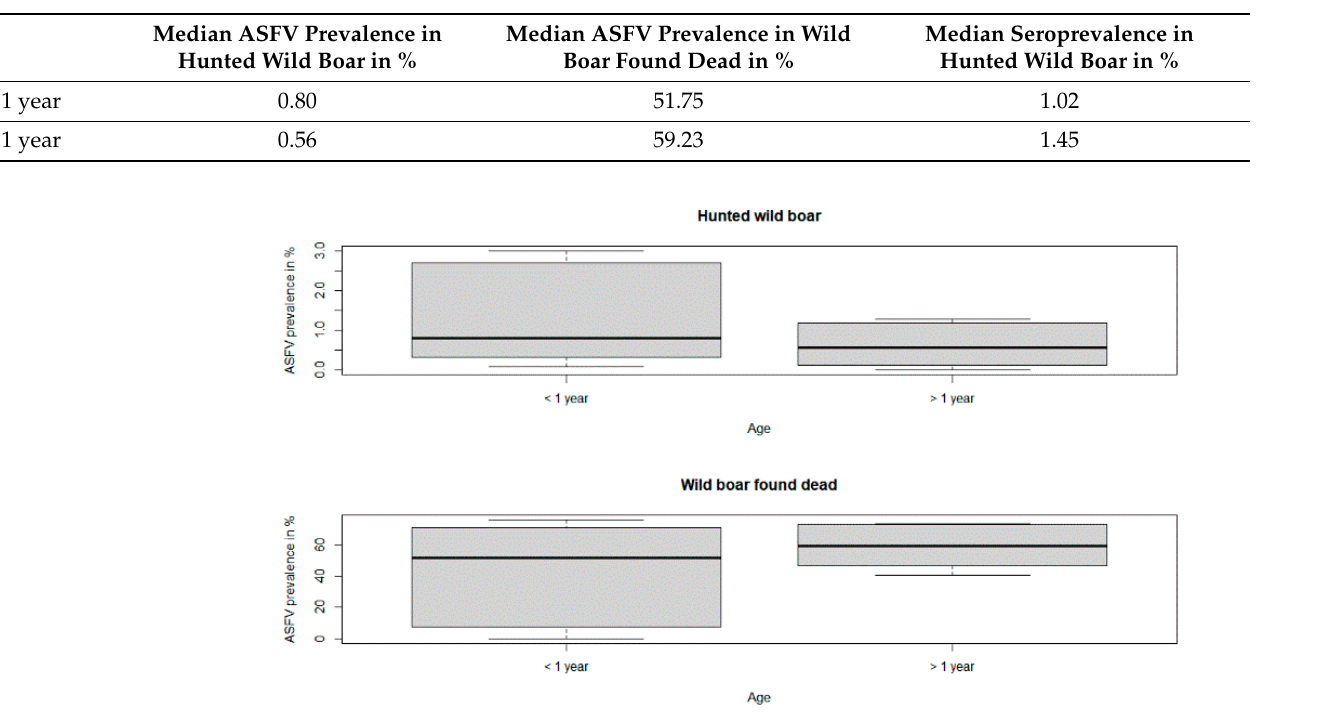
Table 1. Median yearly African swine fever virus and seroprevalence estimates in Lithuanian wild boar from 2016–April 2021 for each age class. Median ASFV Prevalence in Hunted Wild Boar in %